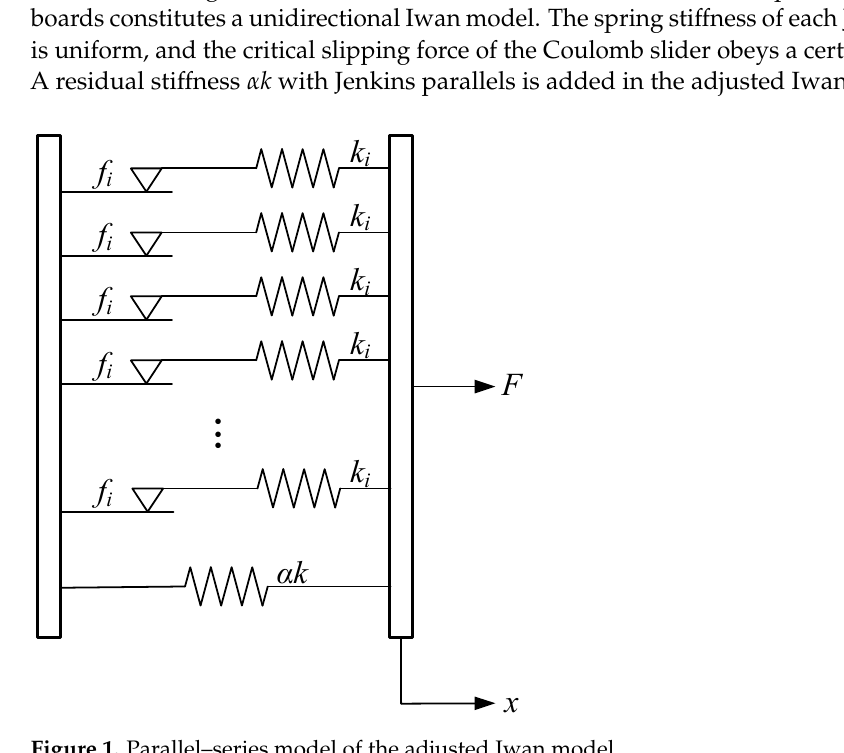
Figure 1. Parallel–series model of the adjusted Iwan model.